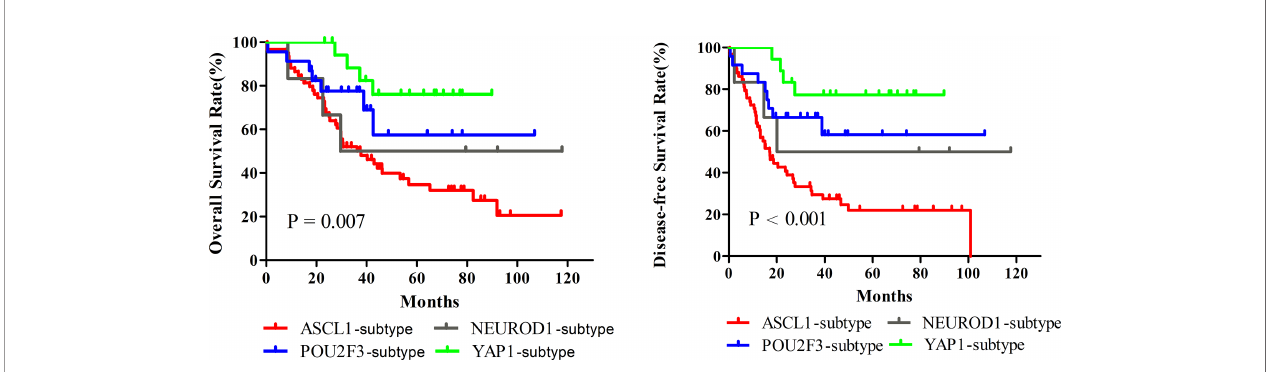
FIGURE 5 | Survival Comparison among Dominant Molecular Subtypes determined by Immunohistochemical Staining of Primary Small Cell Lung Cancer. A total of 124 patients were utilized to perform Kaplan-Meier analyses, and fourteen tumors were excluded in this analysis because of detachment during immunohistochemical staining.